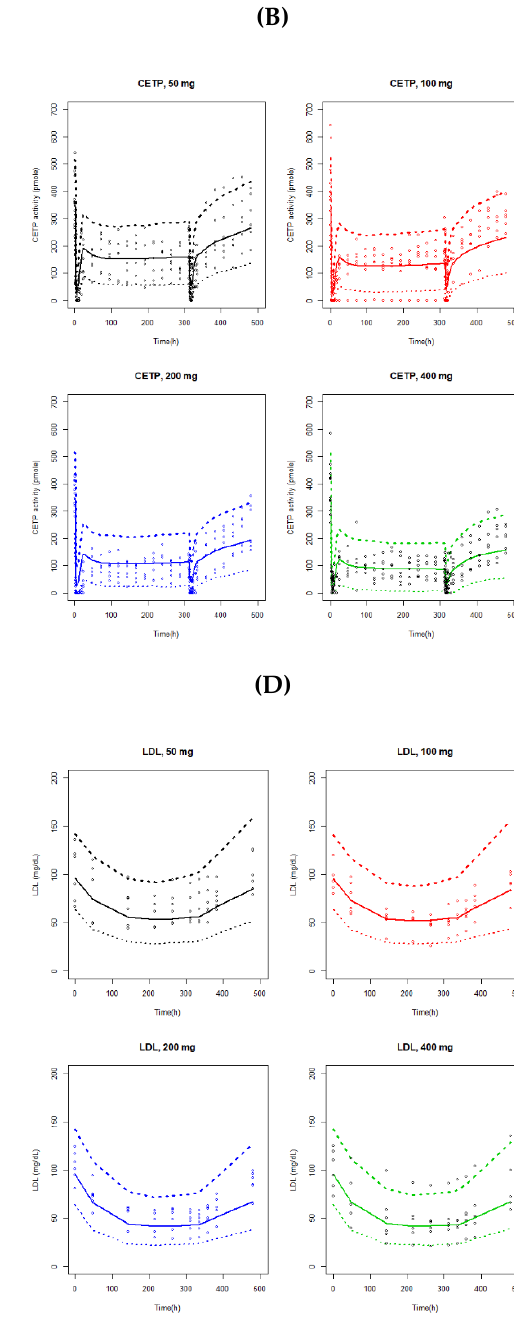
Black line is line of identity, and gray line is locally weighted regression smooth line. IWRES, individual weighted residuals.